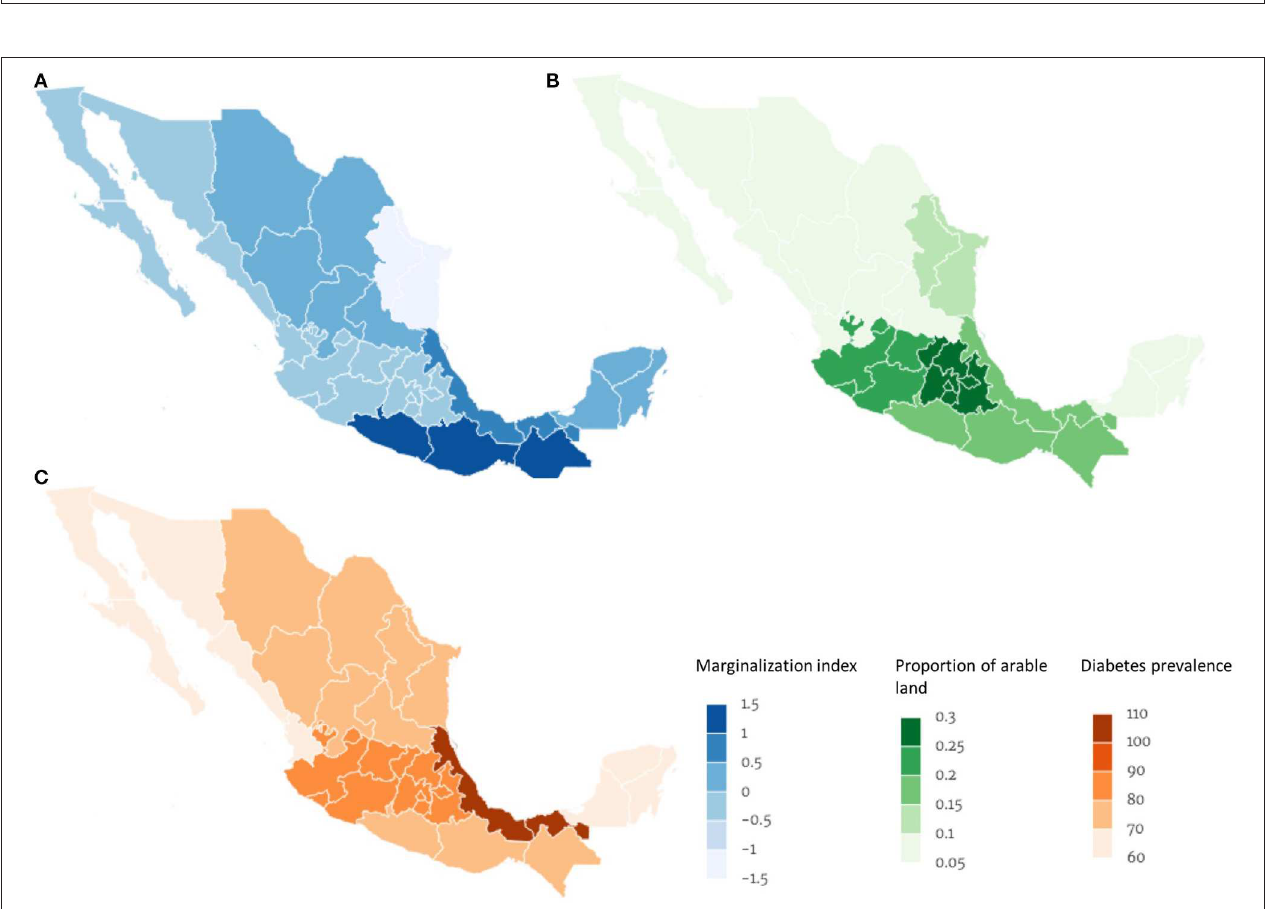
FIGURE 5 | Distribution analysis of (A) socioeconomical (marginalization index); (B) environmental (proportion of arable land); and (C) health (prevalence of diabetes) variables at Mexican ecoregions.